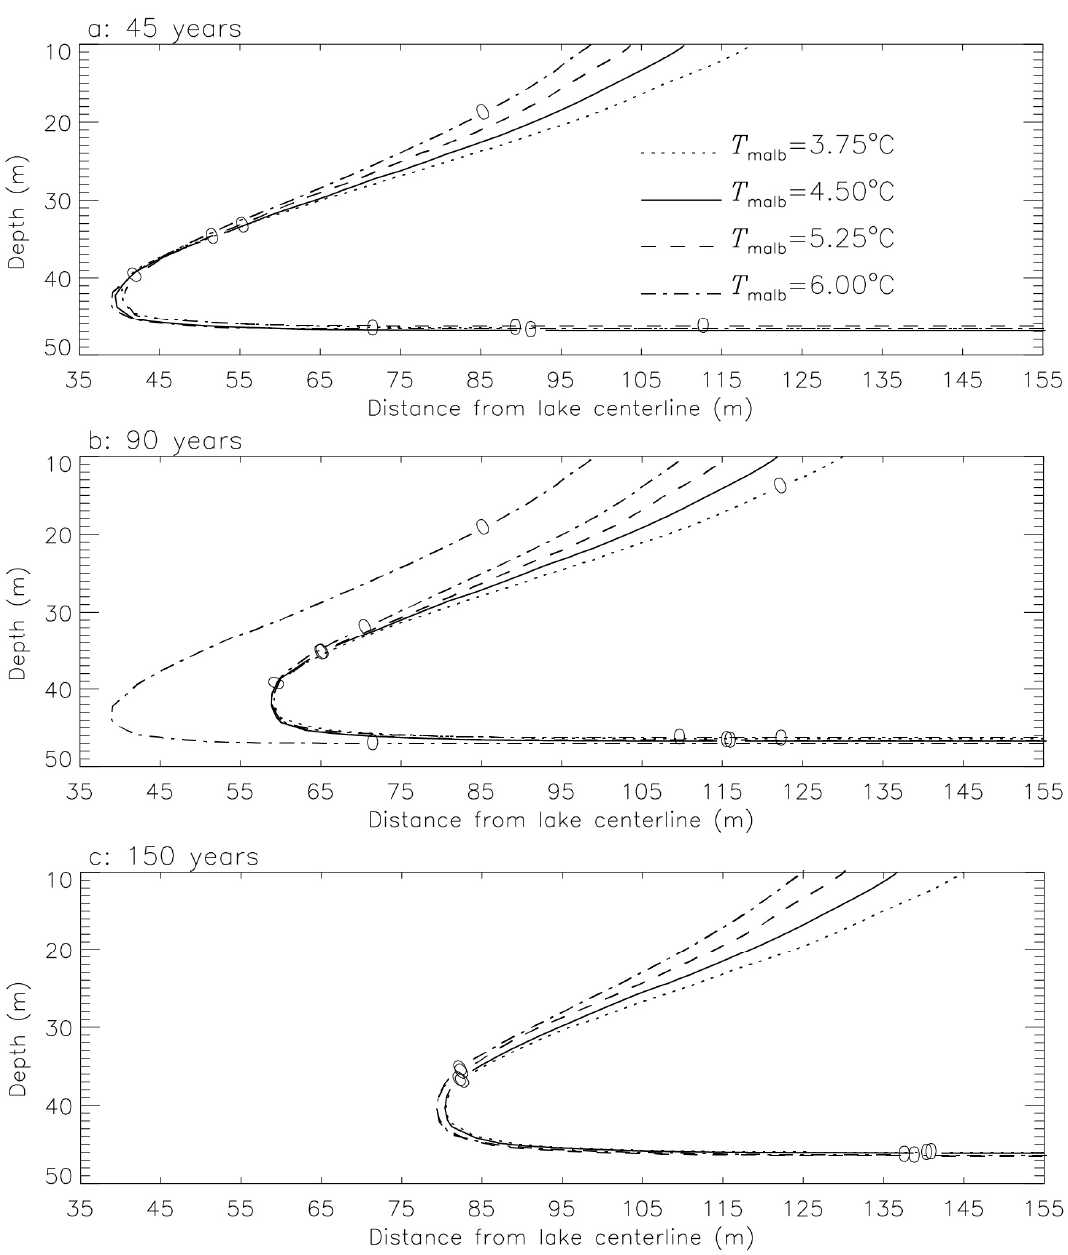
Figure 6. The vertical profiles of the taliks below the thermokarst lakes with di ff erent mean annual lake bottom temperatures on the last day of years ( a ) 45, ( b ) 90, and ( c ) 150 after each open talik formation. Significantly, open taliks beneath thermokarst lakes with di ff erent MALBTs have the same mean open talik lateral progress rates of 8.4 m / year, 6.4 m / year, and 5.3 m / year at years 45, 90, and 150 after the open taliks’ formation. These results suggest that variations in the MALBT have an insignificant influence on open talik lateral progress. This is due to the fact that thermokarst lakes with lower lake bottom temperatures had longer lake radii when the open talik formed, and the ground under the lake thus had a higher temperature because of the heat source e ff ect of lake water. For example, 150 years after open talik formation, the minimum distances from the open talik profile to the lake centerline below the four lakes were all about 80.0 m; the thermokarst lakes with MALBTs of 3.75 ◦ ◦ 5.25 C, and 6.0 C formed for 613 years, 573 years, 544 years, and 518 years, and the corresponding lake radii reached 159 m, 149 m, 142 m, and 135 m,